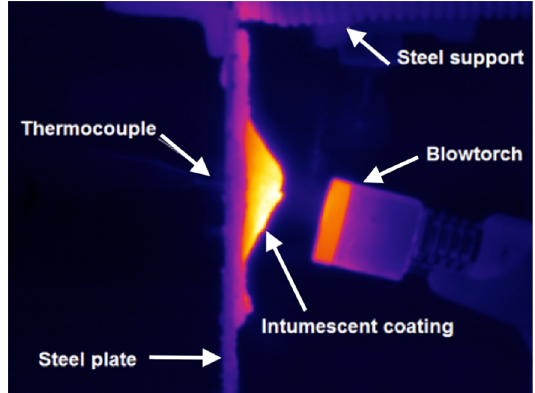
Figure 1. Experimental scheme of the fire resistance test.